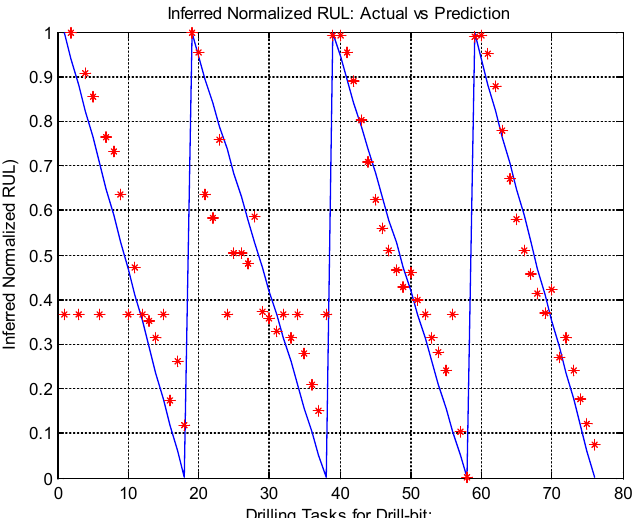
Figure 4. Population of each cluster identified by the MIRGKL algorithm.